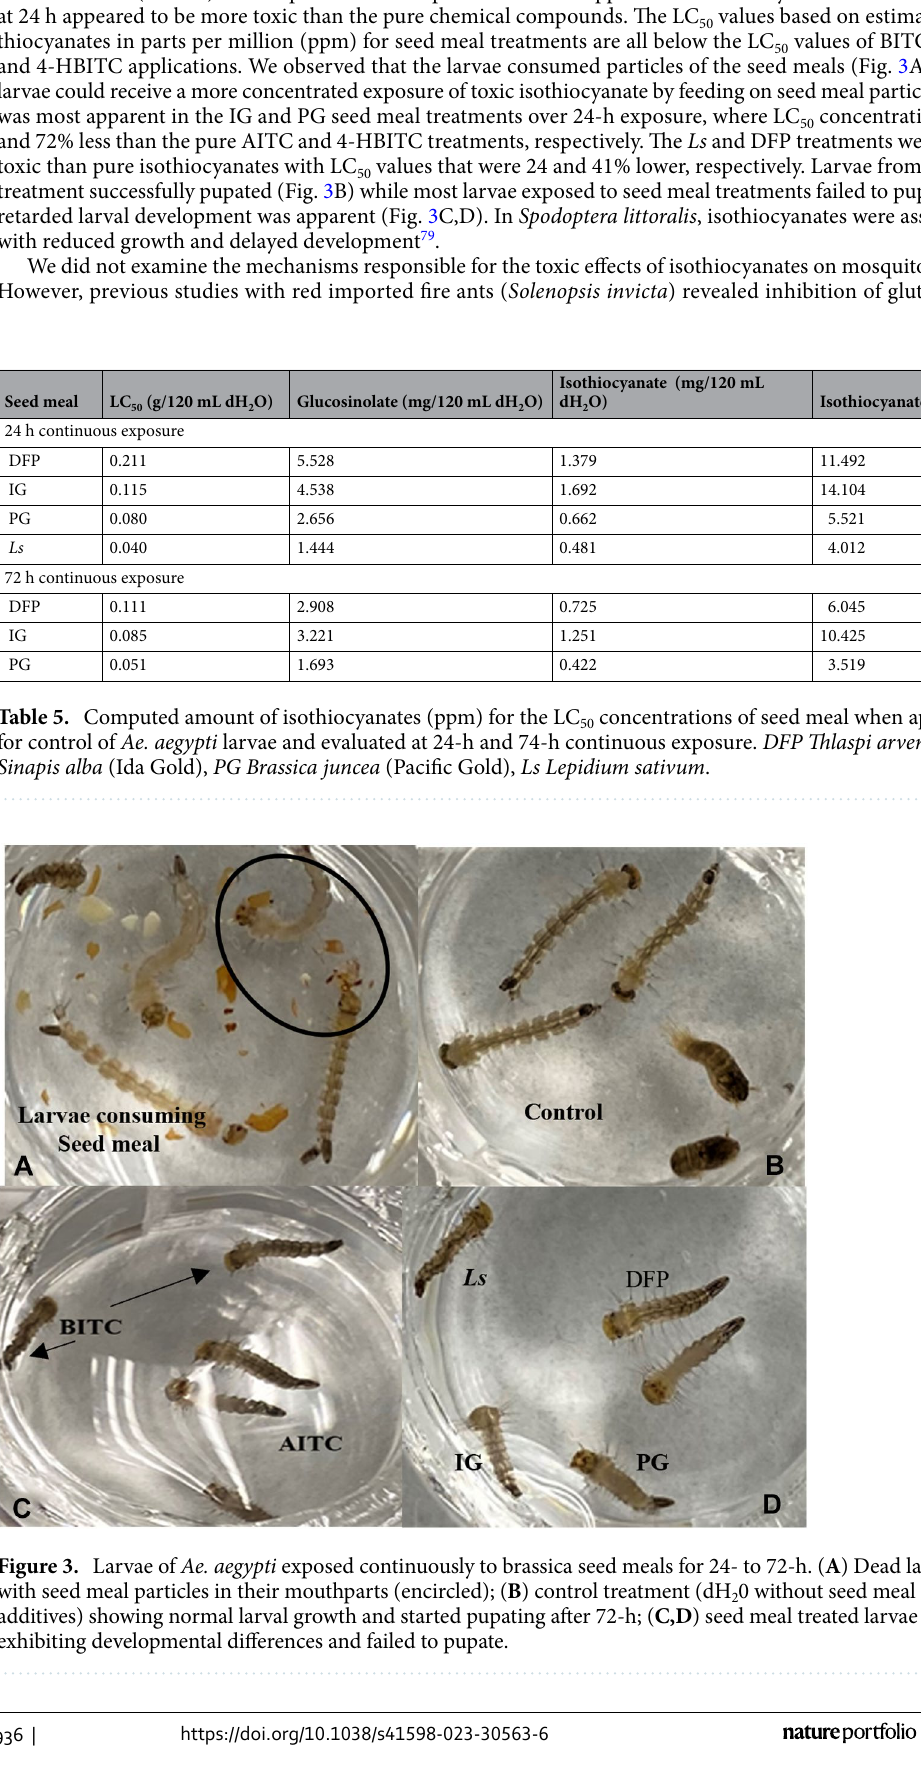
Figure 3. Larvae of Ae. aegypti exposed continuously to brassica seed meals for 24- to 72-h. ( A ) Dead larvae with seed meal particles in their mouthparts (encircled); ( B ) control treatment (dH 2 0 without seed meal additives) showing normal larval growth and started pupating after 72-h; ( C,D ) seed meal treated larvae exhibiting developmental differences and failed to